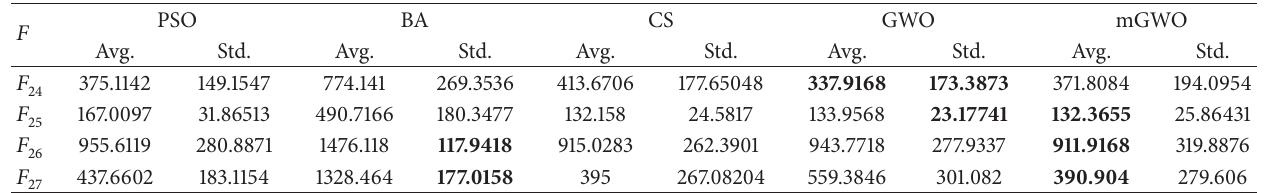
Table 8: Results of composite